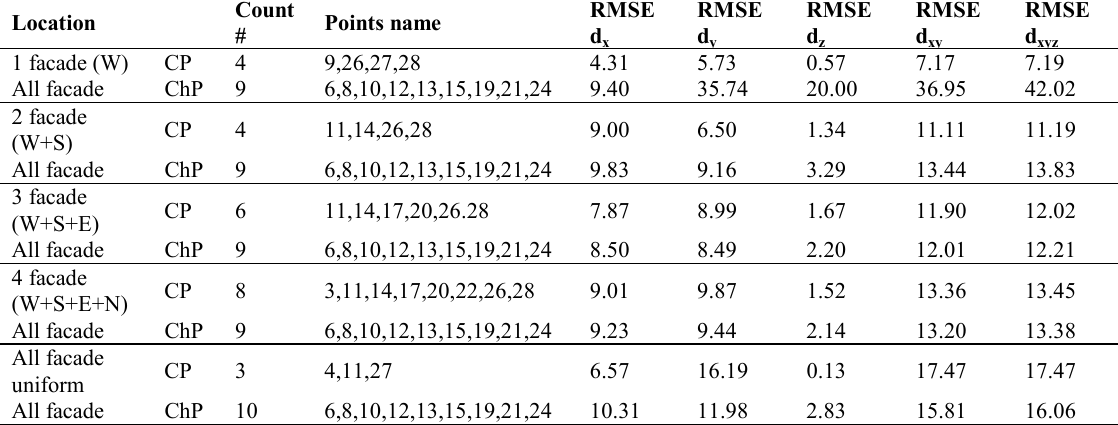
Table 2. With loop close, RMSE of residuals on CPs and ChPs